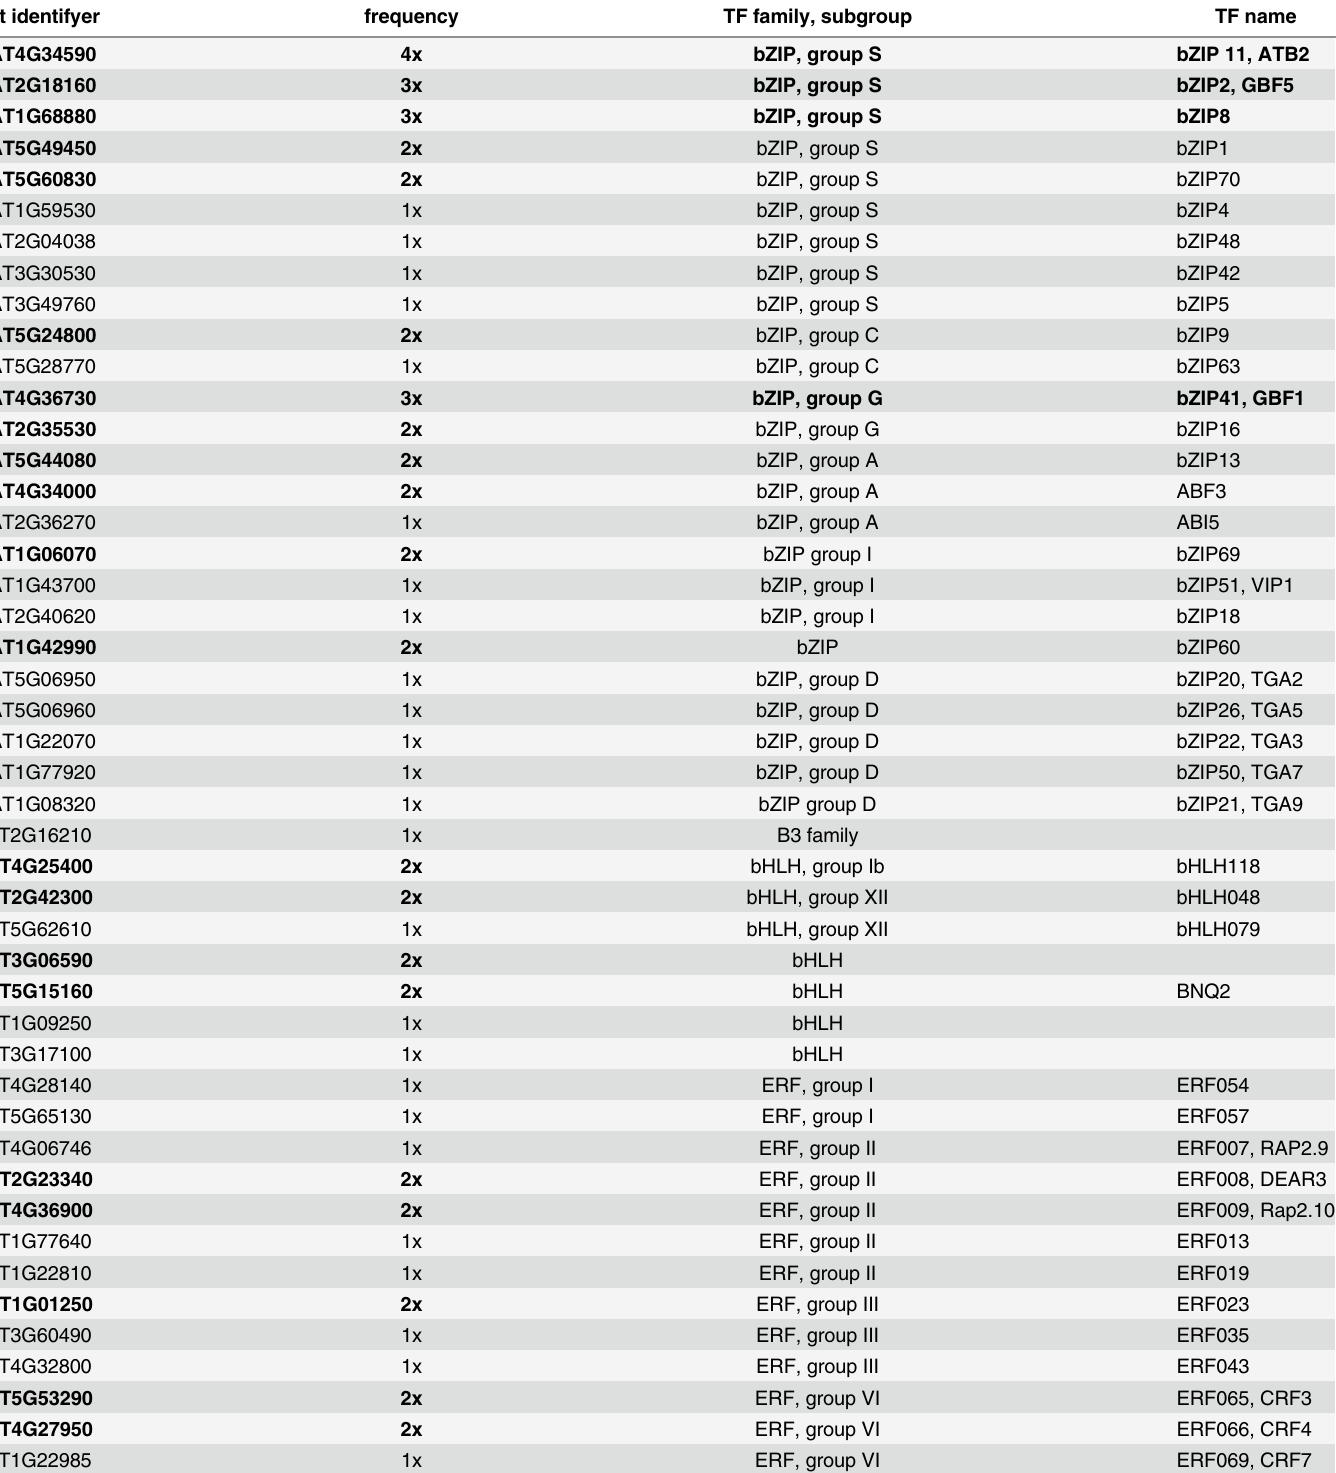
Table 1. Overview of the screening results. TF transgenes were PCR-amplified from those At TORF-Ex lines which display restored root growth on 9-HOT. Frequency: TFs found 3 – 5 time were given in bold. At